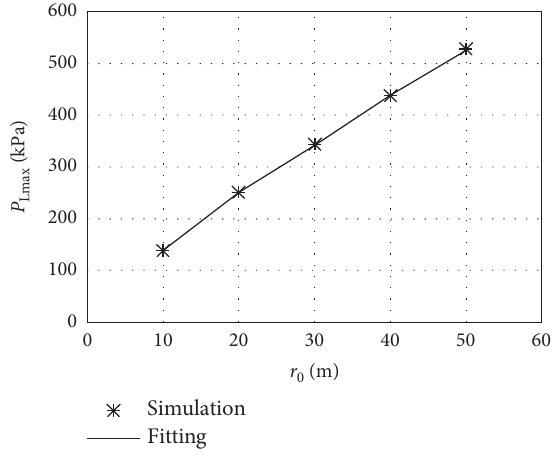
Figure 3: Relation between p